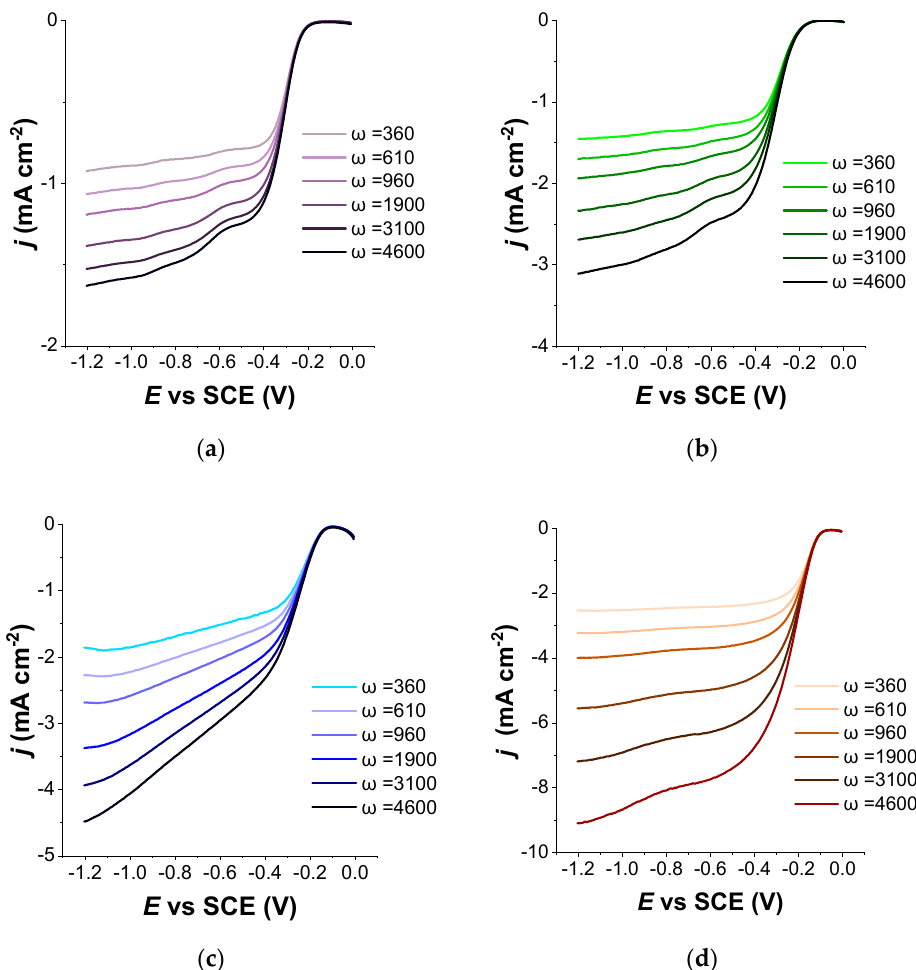
Figure 4. RDE polarization curves of GC electrodes modified with wood-based, nitrogen-doped activated carbons synthesized at ( a ) 650 °C, ( b ) 700 °C, ( c ) 750 °C and ( d ) 800 °C temperatures in O 2 saturated 0.1 M KOH ( ν = 10 mV s − 1 ) measured at various rotation speeds.